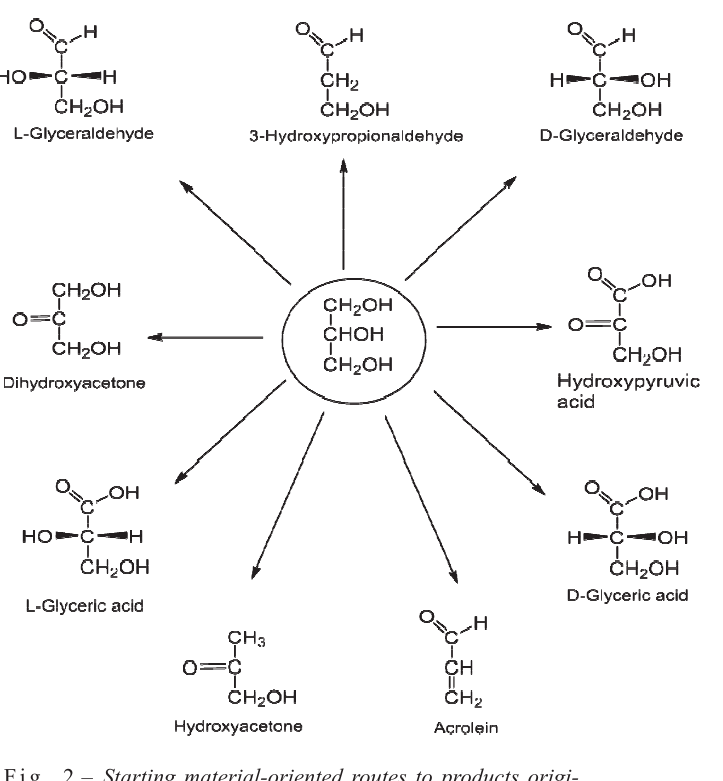
Fig. 2 – Starting material-oriented routes to products origi- nating from glycerol